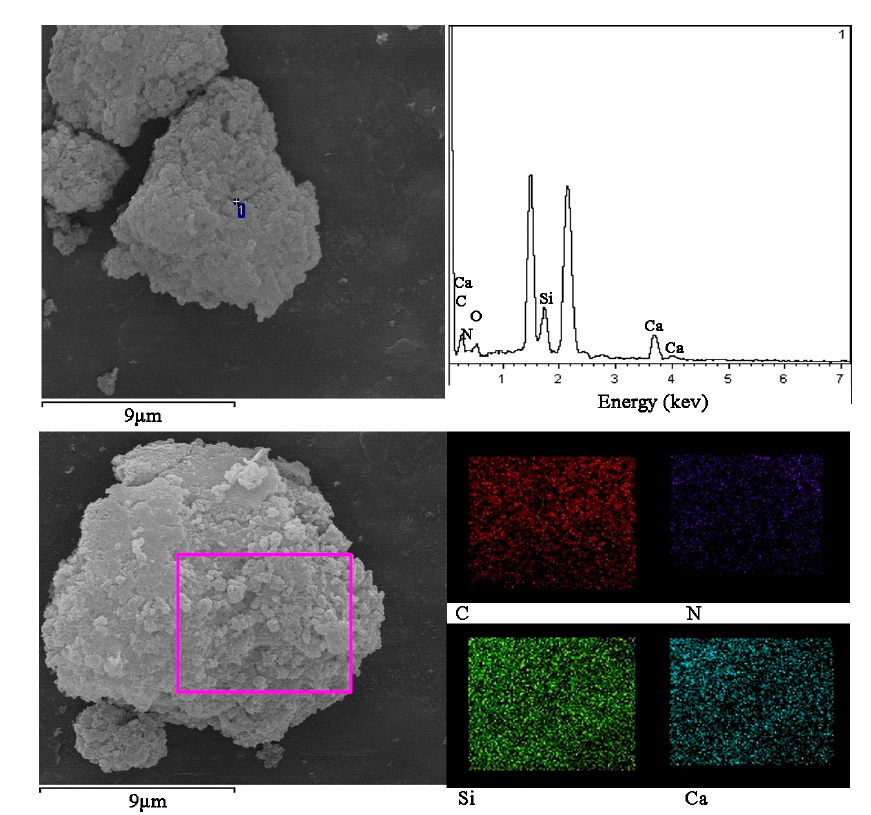
Figure 15. The EDS of CS015-300 after reaction.